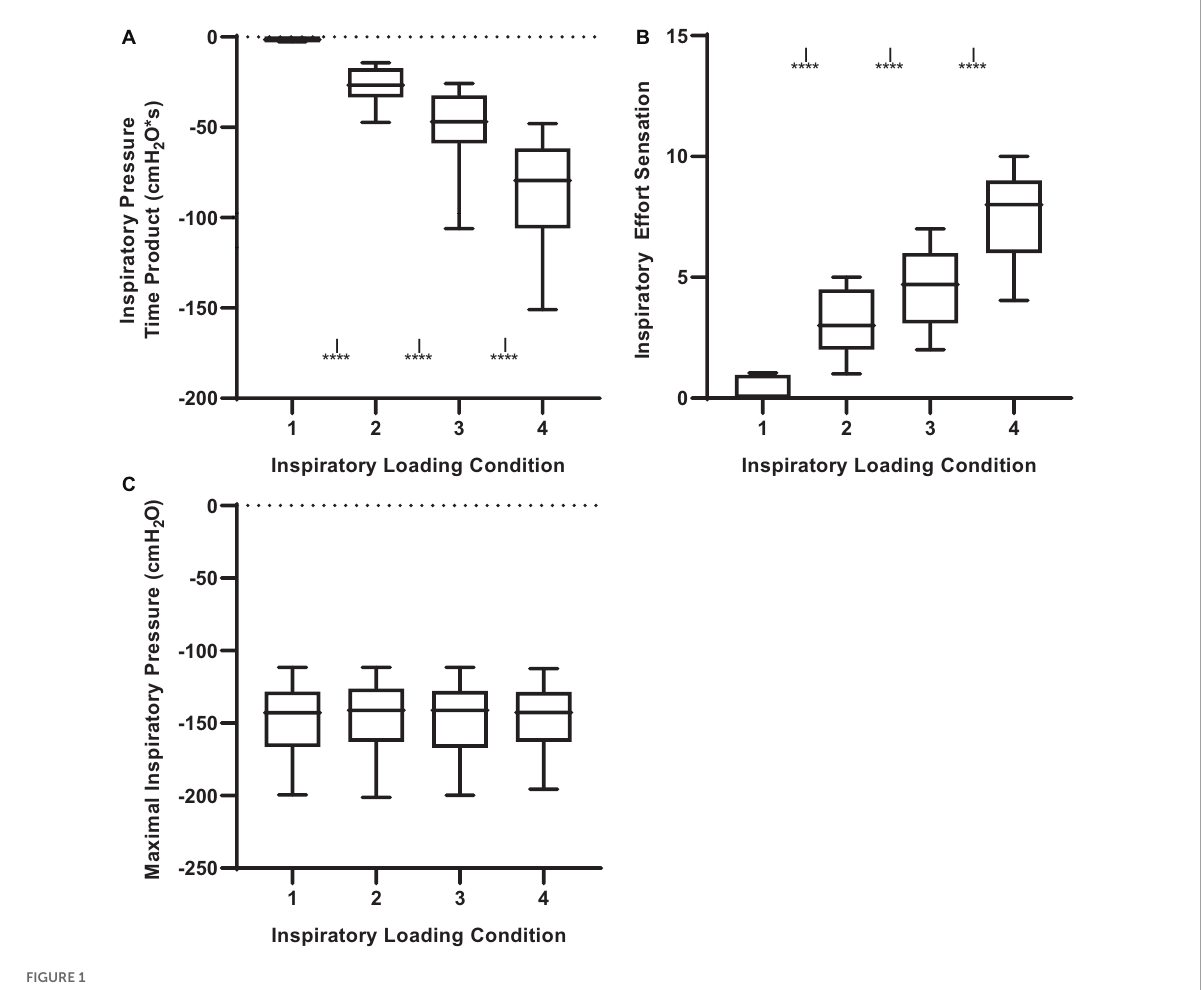
FIGURE1 Inspiratory pressure-time product, effort sensation and maximal inspiratory pressure (MIP) across inspiratory threshold loading conditions during masked conjunctive continuous performance trials. (A) Depicts the differences in inspiratory pressure time product across loading conditions. (B) Depicts the differences in Inspiratory effort sensation across loading conditions. (C) Depicts the differences in maximal inspiratory pressure across loading conditions. The upper and lower limits of the box represent the 95% CI, the horizontal line in the box represents the mean, and the whiskers represent the SEM. ****Significant difference from previous load condition, P < 0.001. I Significant difference from load condition 1, P <